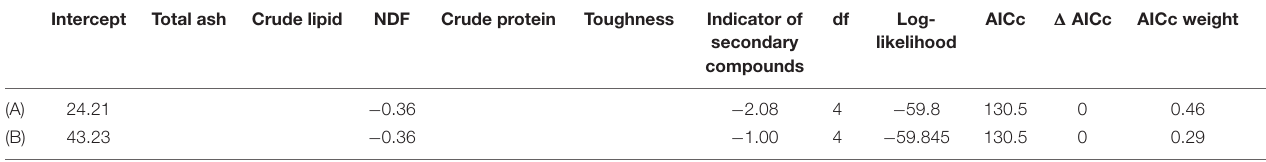
TABLE 2 | Summary of model selection for linear models used to examine the effects of several leaf traits (e.g., chemical properties, toughness and indicators of secondary compounds) on leaf digestibility (Gp at 24 h) without PEG (A) and with PEG (B) (only models with ≤ (cid:49) AIC 2 are shown). Intercept Total ash Crude lipid NDF Crude protein